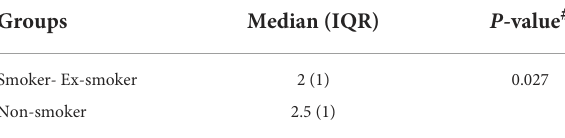
TABLE 4 Median score of knowledge toward e-cigarettes according to smoking status.